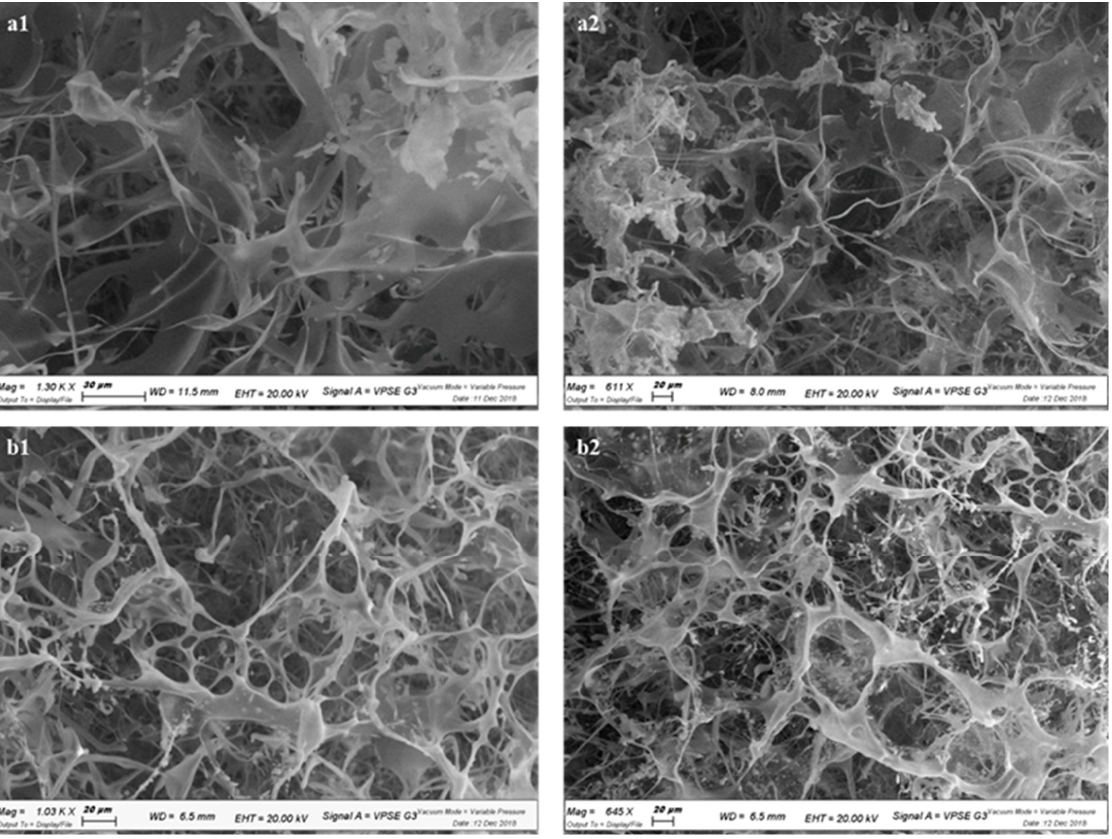
Figure 4. SEM images of HA (panels a1, a2) and HA–Arg (panels b1, b2). SEM scale bar: 20 µm (panels a2, b1, b2), 30 µm (panel a1).